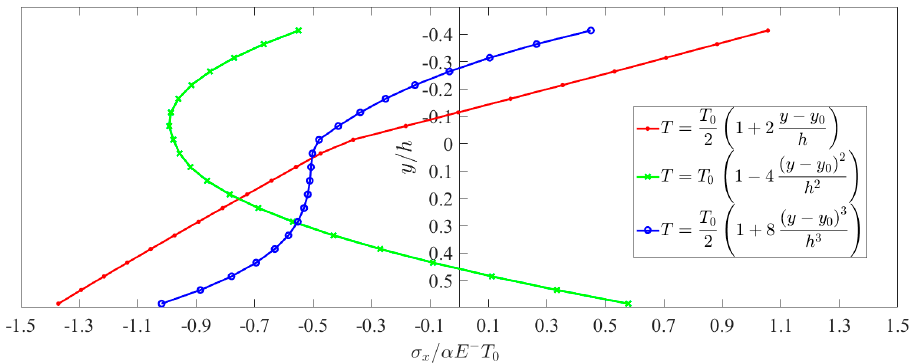
Figure 11. The total stress when E + = E − and α E − T 0 / q = 20.